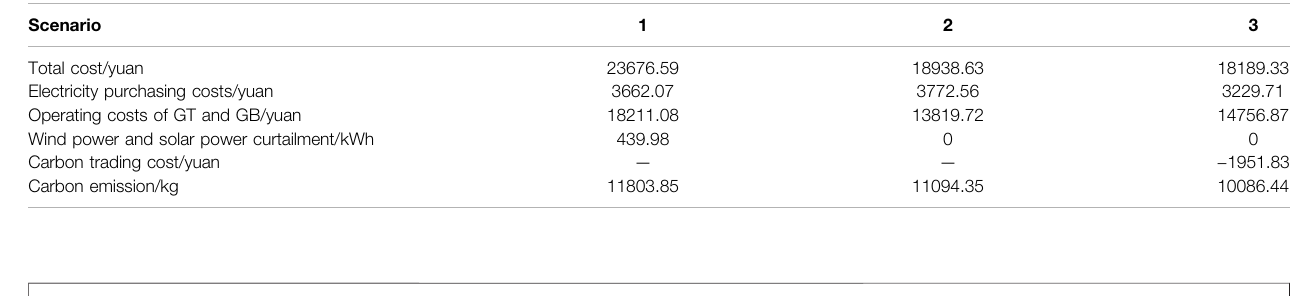
TABLE 3 | Costs of each scenario.